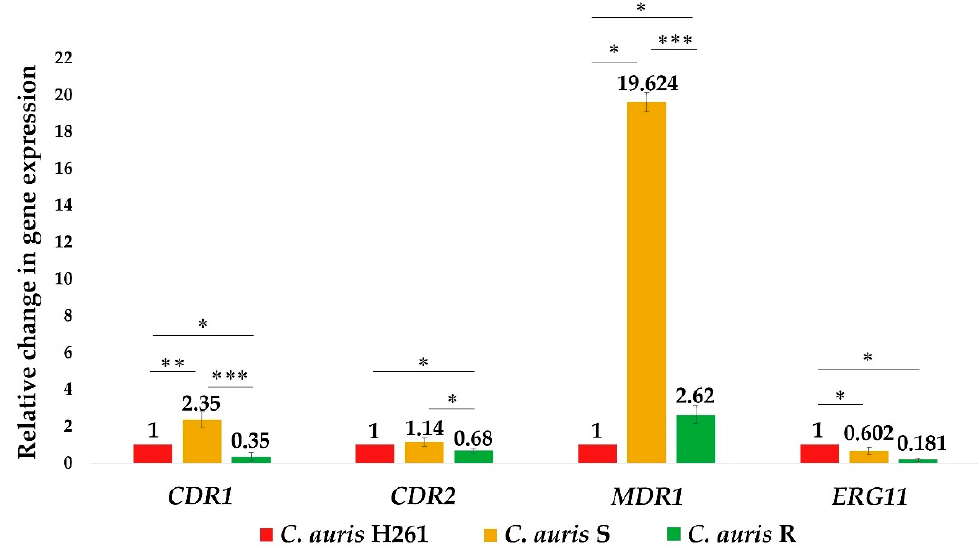
Figure 1. Basal expression of the CDR1, CDR2, MDR1, and ERG11 genes in C. auris isolates. The relative expression was calculated by qPCR using the 2 − ∆∆ CT method with respect to the housekeeping gene ACT1 and using the susceptible isolate C. auris H261 for normalization. Data represent the average of 3 independent experiments performed in triplicate ± SD. p -values < 0.05 were considered significant: * <0.05; ** < 0.01; *** <0.001.